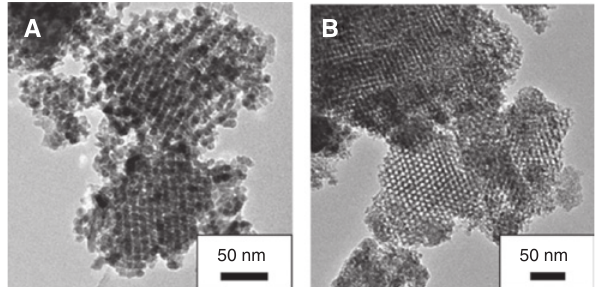
Figure 23: HRTEM images of (A) Co-KIT6 and (B) Co-SBA16. Repro- duced from [136] with permission from Elsevier BV.